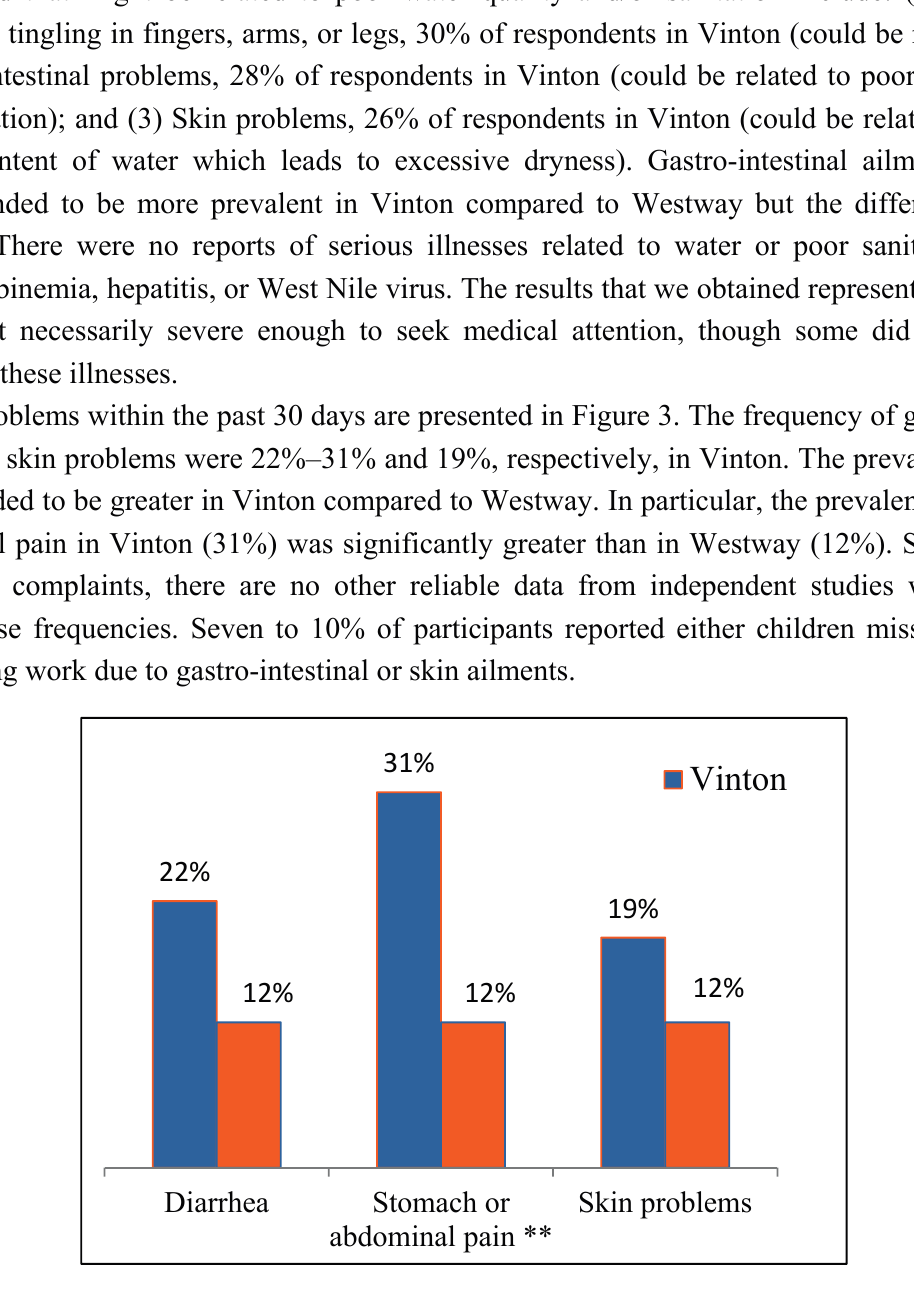
Figure 3. Self-reported ailments in the last 30 days from survey in Vinton and Westway. ** significant difference between communities using chi-square test, p = 0.01 (x 2 =